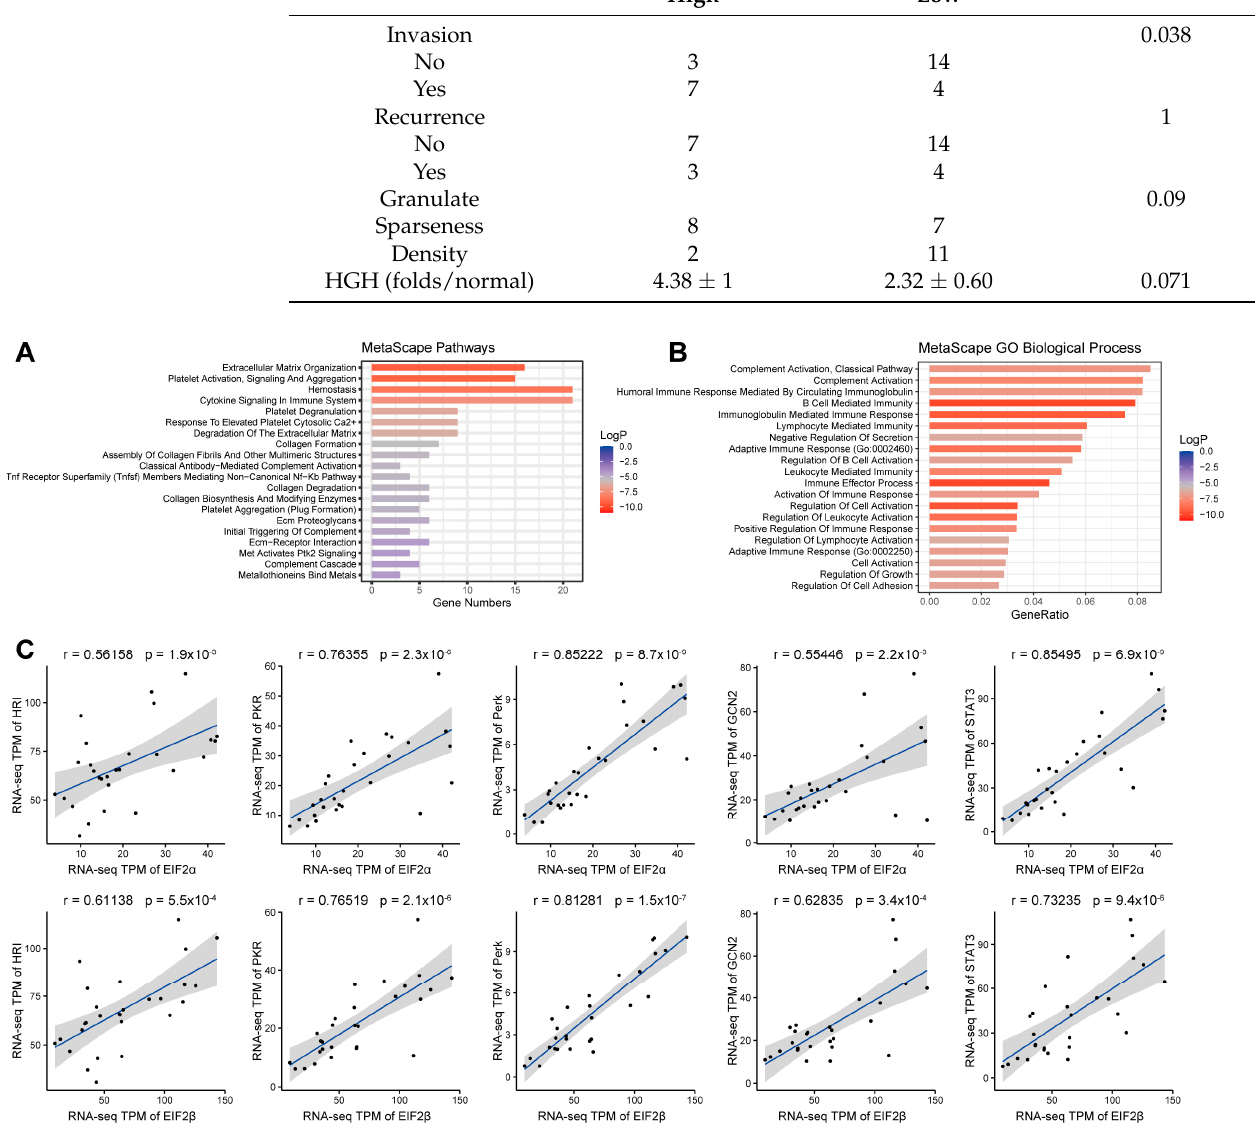
Table 2. Clinically pathological features of patients with somatotroph adenoma.